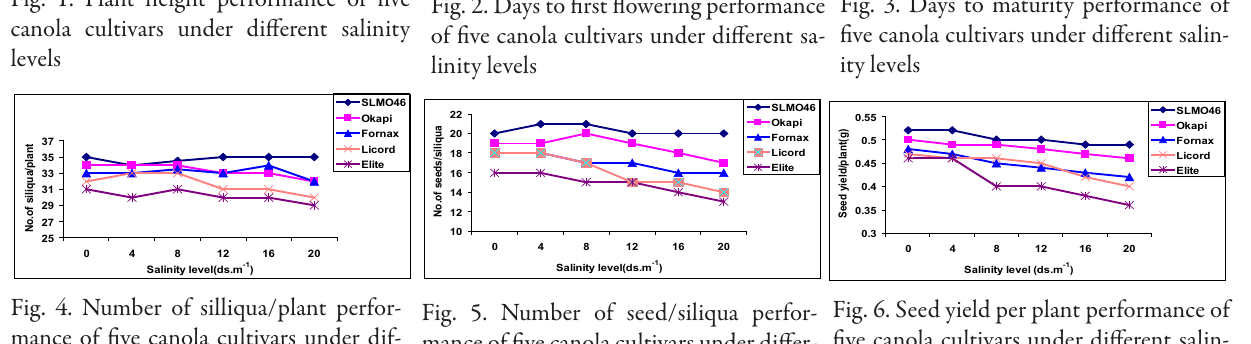
Fig. 4. Number of silliqua/plant perfor- Fig. 6. Seed yield per plant performance of Fig. 5. Number of seed/siliqua perfor- five canola cultivars under different salin- mance of five canola cultivars under differ- ity levels ent salinity